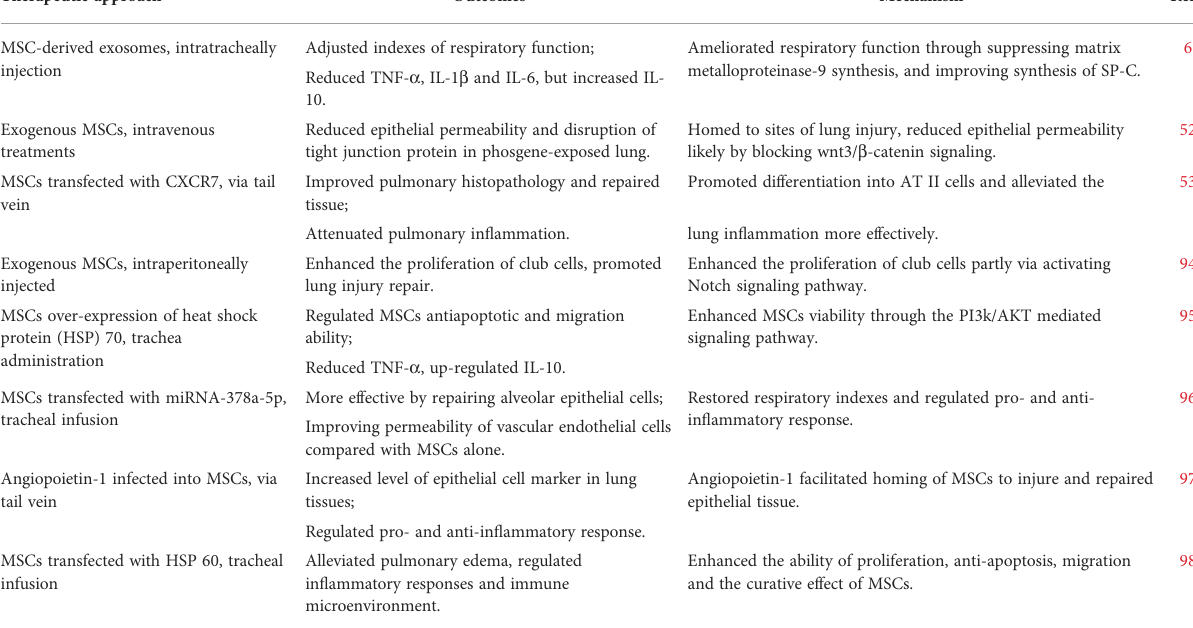
TABLE 2 Summary of MSCs-mediated therapy used in vivo in the treatment of P-ALI. Therapeutic